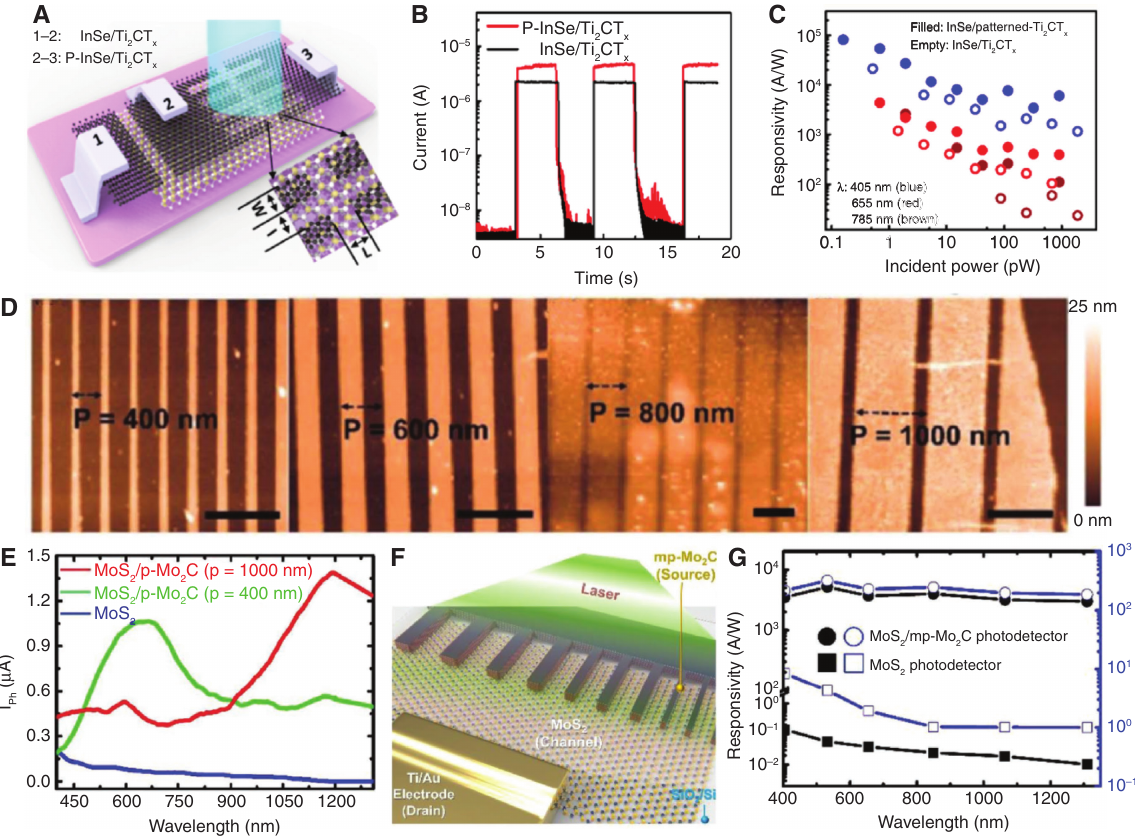
Figure 9: Photodetectors with MXene electrodes and plasmonic nanostructures. (A) Schematic of InSe/Ti CT photodetectors with and without nanoribbon structure. (L = W = I = 250 nm) (B) Time-dependent photo- 2 x response of patterned and unpatterned InSe/Ti CT photodetectors. (C) Calculated responsivity of patterned and unpatterned InSe/ 2 x Ti CT photodetectors under light illumination with different wavelengths. (D) AFM images of patterned Mo 2 x Wavelength-dependent photocurrent profile of MoS photodetector with and without hybrid structure. (F) Schematic of MoS 2 with multiple periods patterned Mo C electrode under light illumination. (G) Calculated responsivity and LtDR as a function of wavelength. 2 (A–C) Reproduced with permission [54]. Copyright 2019, American Chemical Society. (D–G) Reproduced with permission [56]. Copyright 2019,